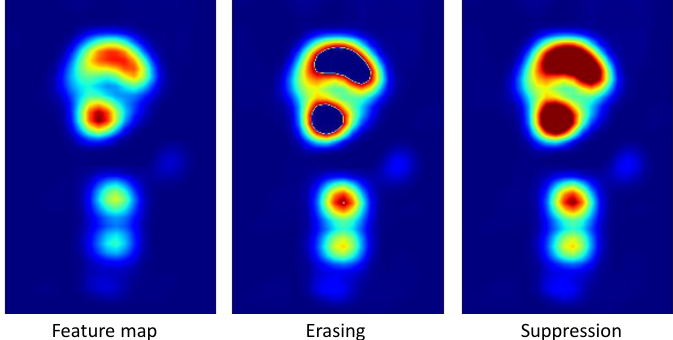
Figure 2. Erasing and suppression —Erasing sets to zero the areas above a certain threshold τ , while suppression sets those areas to τ . In this example, τ = 0.6. The colors of the heatmaps are scaled based on their maximum and minimum